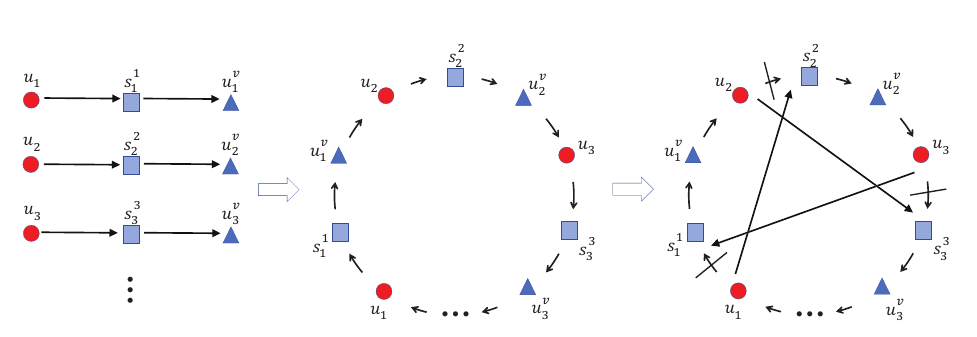
Figure 6. An example of fast-3-Opt heuristic.